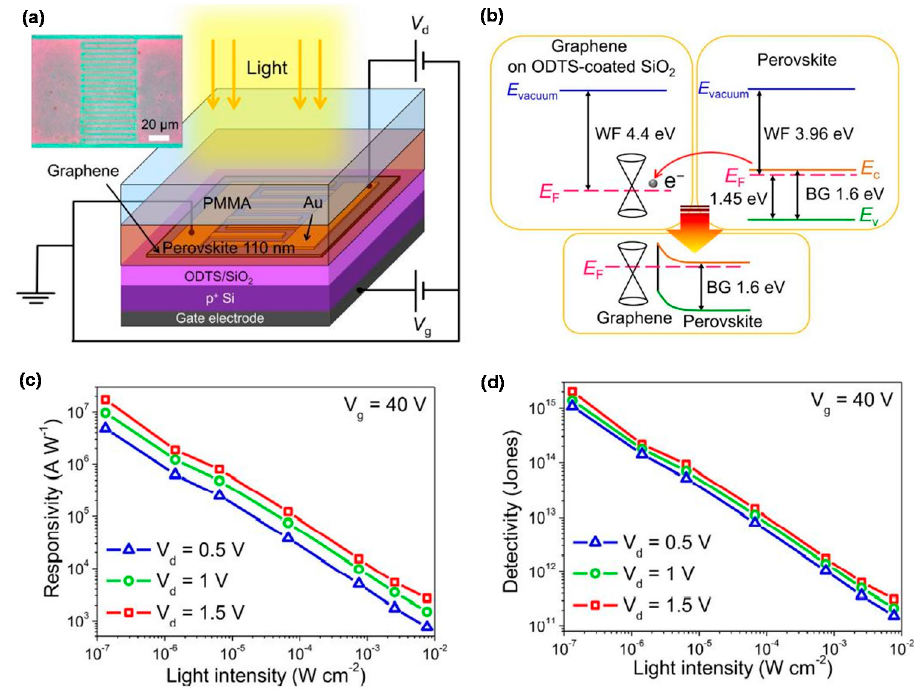
Figure 9. ( a ) Schematic illustration of the graphene–perovskite hybrid phototransistor. The inset shows the top-view optical microscopy image of the device; ( b ) Band diagrams of graphene and perovskite obtained from ultraviolet photoelectron spectroscopy spectra. The schematic diagram of the band bending at graphene/perovskite interfaces is illustrated below; ( c ) Responsivity and ( d ) detectivity of the hybrid phototransistor as functions of light intensity at three selected drain voltages. Reproduced with permission for Figure 9a–d from 2017 Scientific Reports [77].